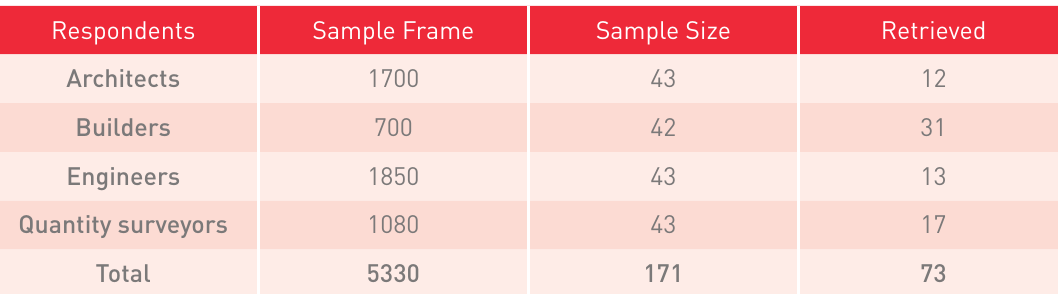
Table 2. Sampling Size of the